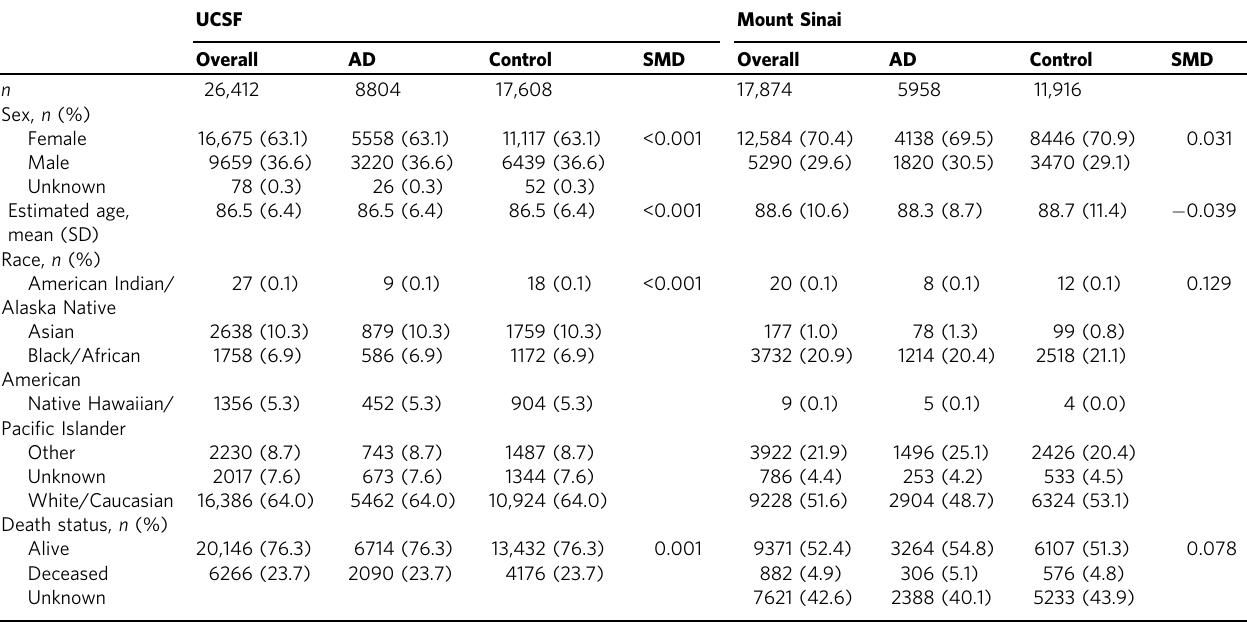
Table 1 Patient demographics.